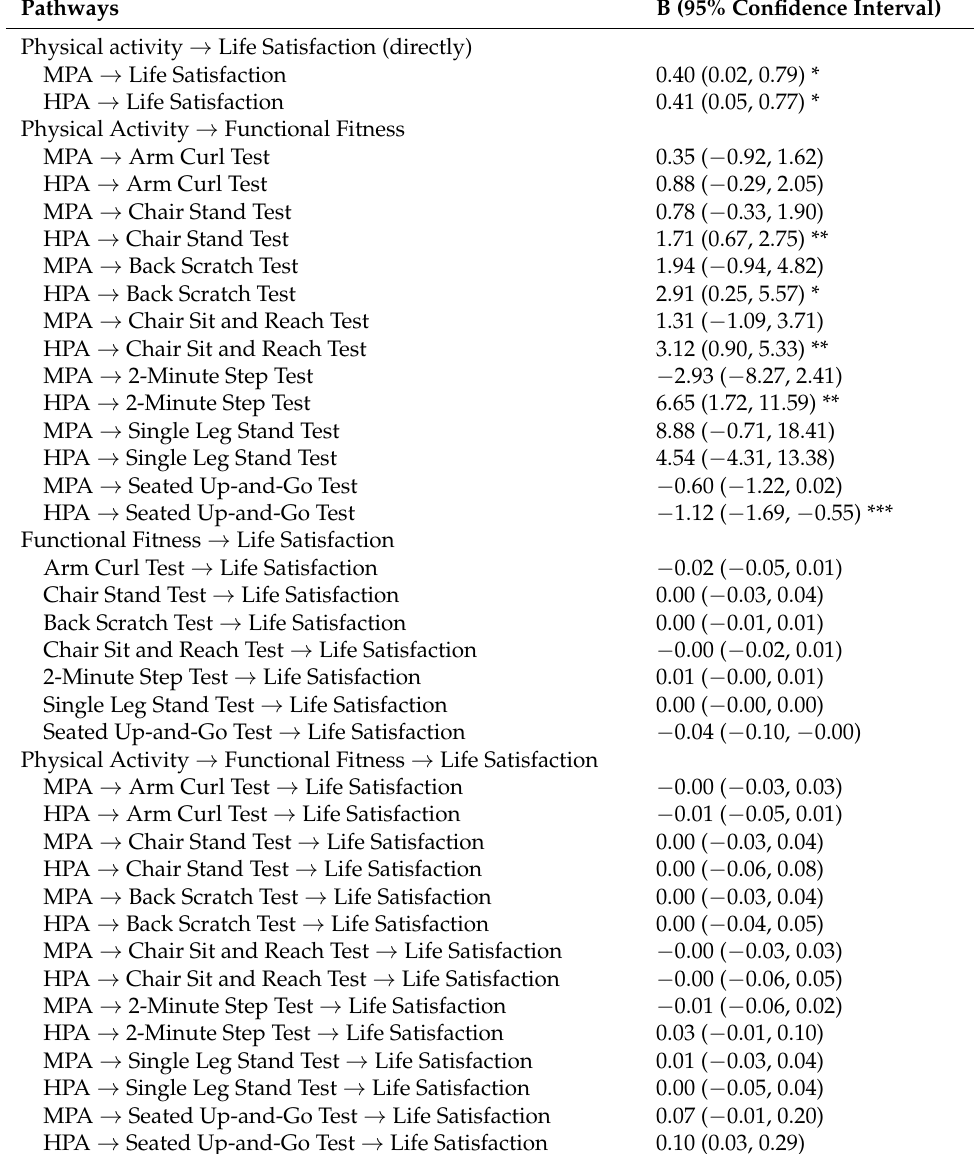
Table 3. The pathways between physical activity, functional fitness, and life satisfaction.